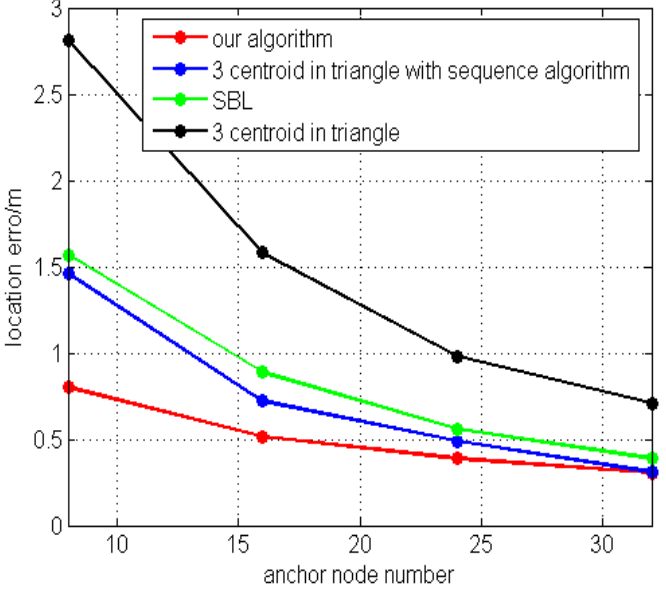
Figure 18. Comparing location algorithm error.